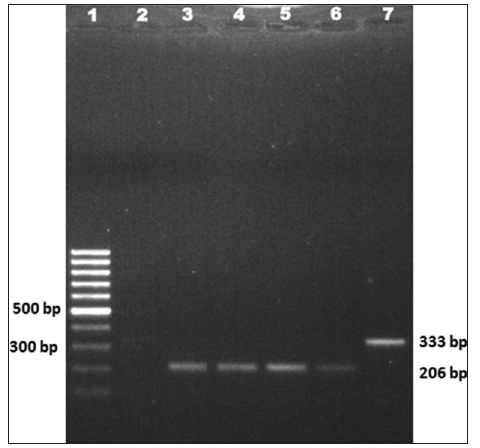
Figure-2: 1.5% agarose gel stained with ethidium bromide showing the amplification of RD9 region (206-bp). Lane 1: 100 bp DNA marker; Lane 2: Negative control; Lane 3: Positive control ( Mycobacterium bovis AN5); Lane 4: ND/1639; Lane 5: ND/1935; Lane 6: ND/1754; Lane 7: Positive control ( Mycobacterium tuberculosis H Table-2: Results of single intradermal tuberculin test, comparative cervical tuberculin test, and gamma interferon assay for the diagnosis of bovine tuberculosis.